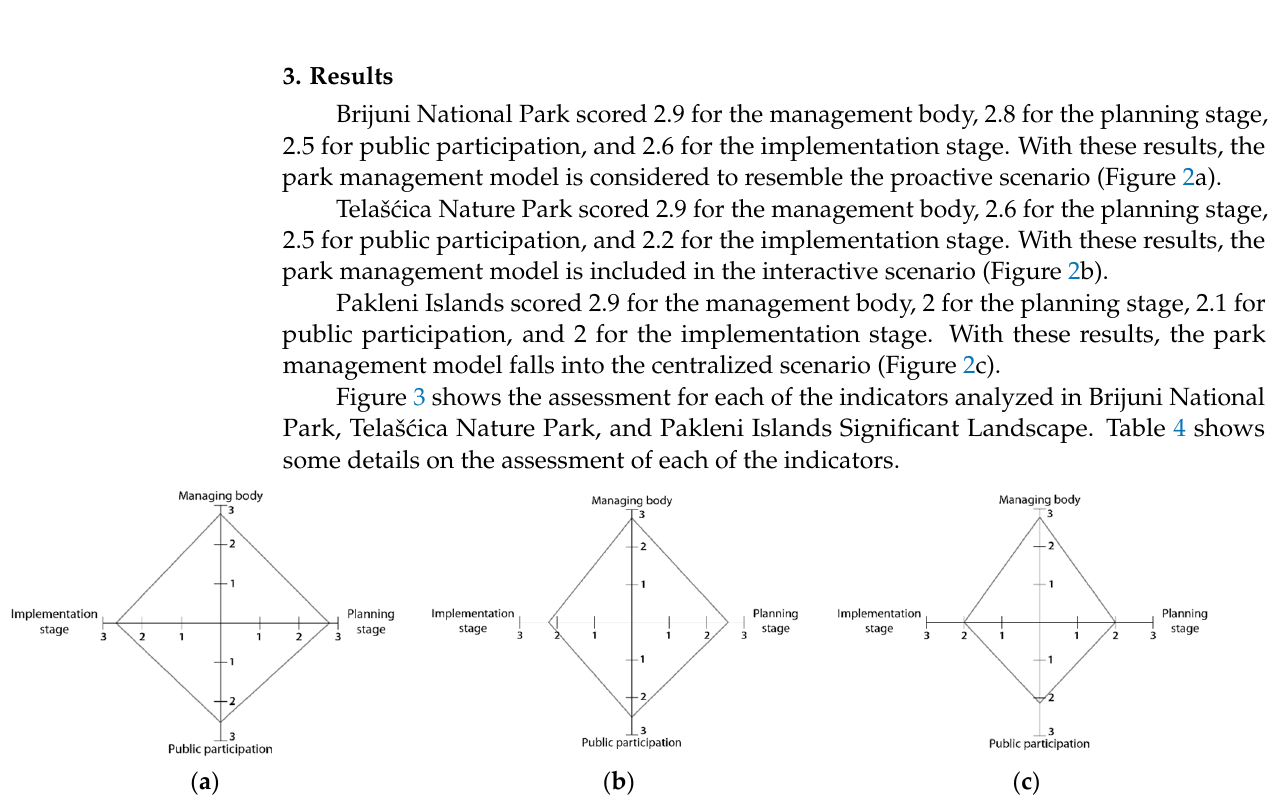
Figure 2. ( a ) Evaluation of the management of Brijuni National Park; ( b ) Evaluation of the management of Telaš ć ica Nature Park; ( c ) Evaluation of the management of Pakleni Islands Significant Landscape. Table 4. Details of the rating given to each